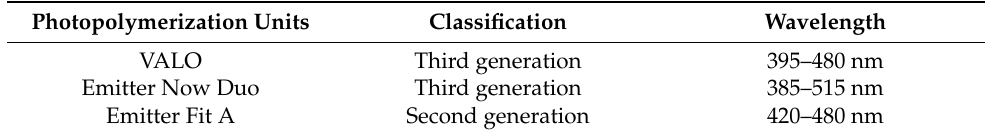
Table 3. Photopolymerization units, classification, and